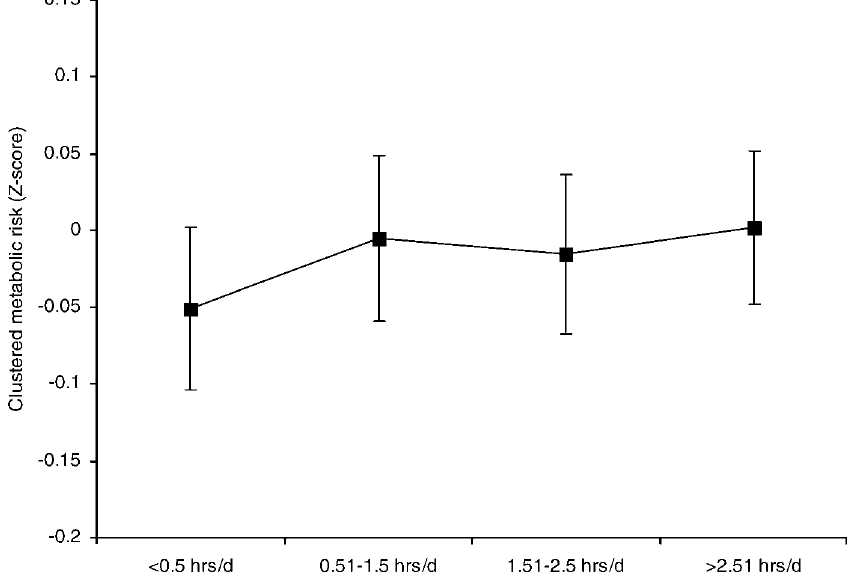
Figure 2. The Clustered Metabolic-Risk Score (Mean 95% CI) Stratified by Quartiles of TV Viewing ( n ¼ 1,485) Data on TV viewing are adjusted for PA, gender, study location, age group, sexual maturity, smoking status, birth weight, and parental SES ( p ¼ 0.053 in continuous